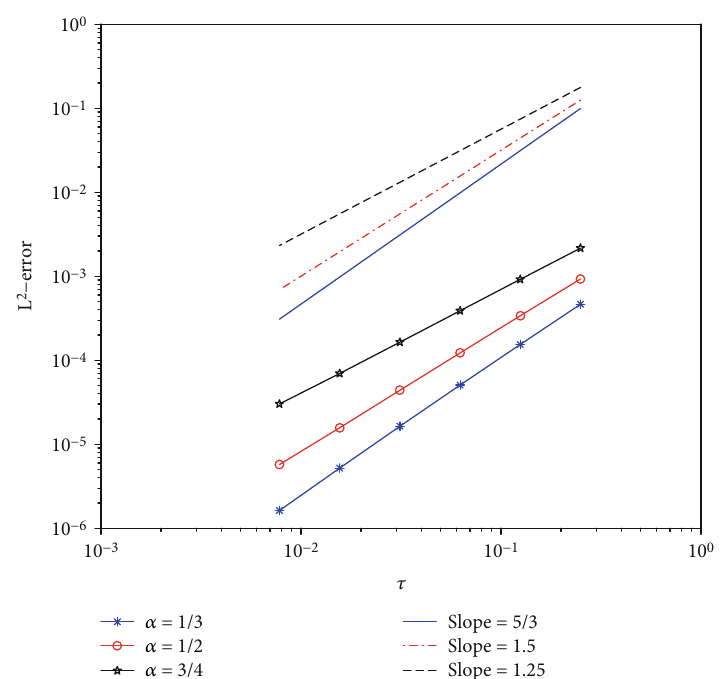
Figure 2: The temporal convergence order of MAM for Example 2.